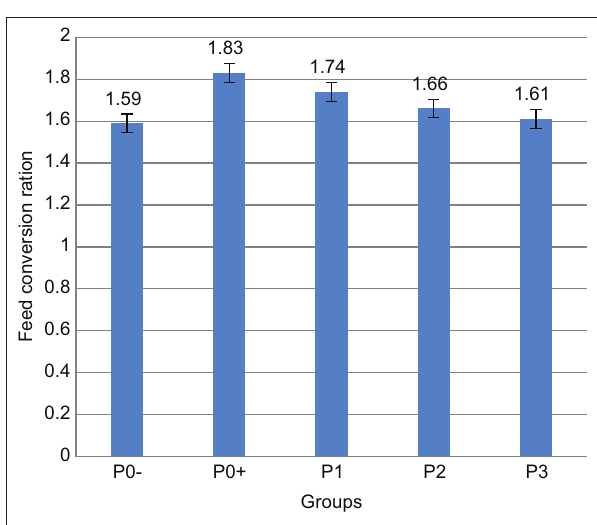
Figure-6: Average of feed conversion ratio in broilers infected with Salmonella pullorum and administered with Meniran extract. P0-= Negative control treatment, P0+= Positive control treatment, P1= Treatment 1 (Group that was administrated with Meniran extract at 5% concentration), P2= Treatment 2 (Group that was administrated with Meniran extract at 10% concentration), P3= Treatment 3 (Group that was administrated with Meniran extract at 20% concentration). The administration of Meniran extract shows a gradual decrease in feed conversion ratio of broiler chickens infected with Salmonella pullorum than the positive control group